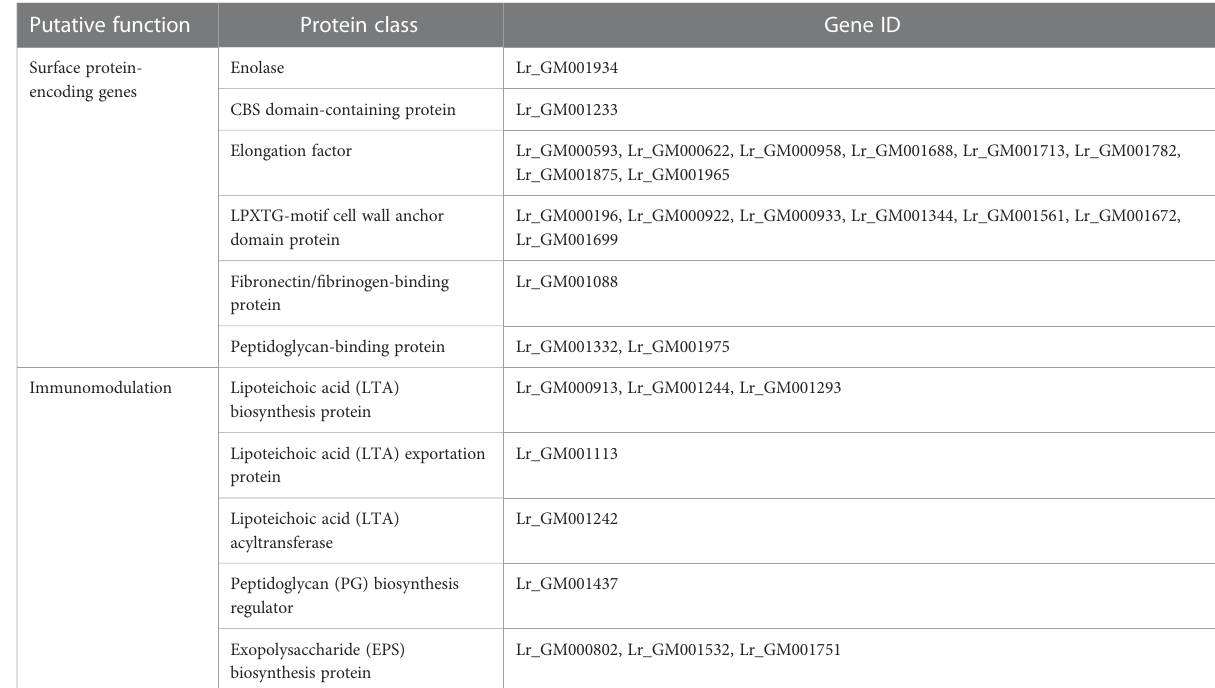
TABLE 2 Molecular determinants of host-bacteria interaction associated